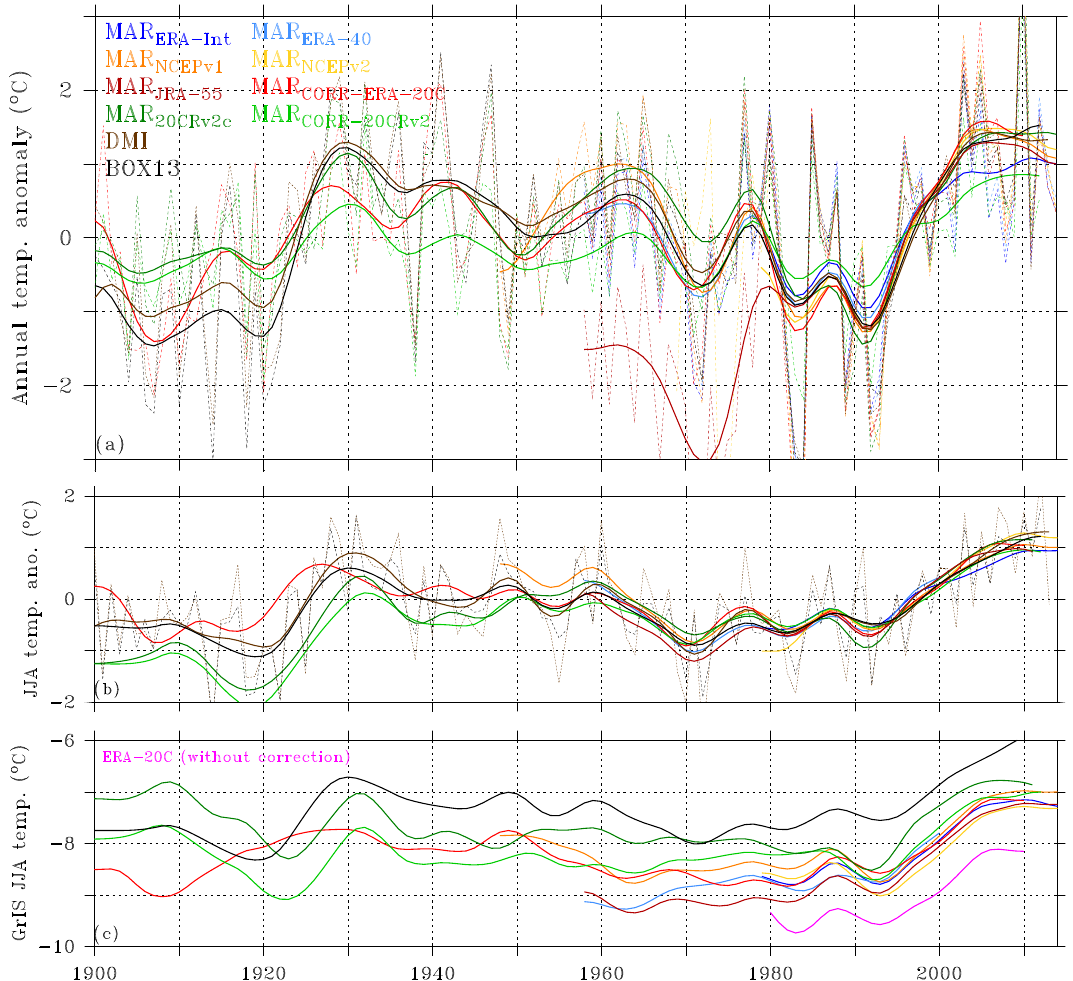
Figure 7. (a) Time series of the annual SW Greenland near-surface temperature (built by merging series of the Ilulissat, Nuuk and Qaqortoq coastal weather stations from the Danish Meteorological Institute,DMI) as observed (in brown) according to Cappelen et al. (2014), retrieved from the BOX13 reconstruction (in black) and as simulated by MAR with the different forcings. Values are anomalies with respect to 1980–2010 and 10-year running mean are shown. (b) Same as (a) for the summer (JJA) SW Greenland near-surface temperature. (c) Mean GrIS summer (JJA) near-surface temperature (in ◦ C) as simulated by MAR using the different forcings. The ERA-20c (without temperature correction) forced MAR time series as well as the BOX13 reconstruction-based time series are also